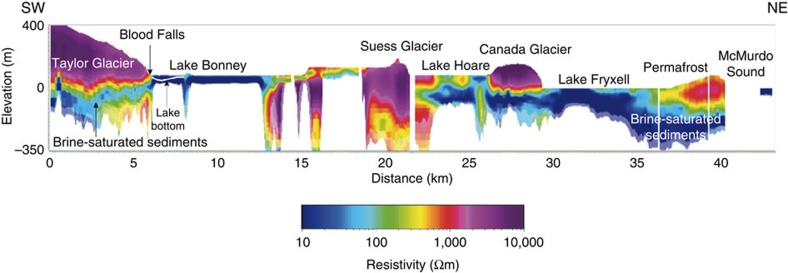
Resistivity cross-section for the length of the Taylor Valley.Resistivity profile along the length of the Taylor Valley (flight line denoted in red in Fig. 1b). Low resistivities near McMurdo Sound to Lake Hoare interpreted as hydrological connectivity of brine in sediments extending from the coastal margin inland and beneath the Canada Glacier. To the west, resistivities increase below Suess Glacier and again towards Lake Bonney. In the Bonney Basin, low-resistivity patterns suggest connectivity of brine-rich sediments below the Taylor Glacier with proglacial Lake Bonney at the glacier terminus and near the location of Blood Falls.